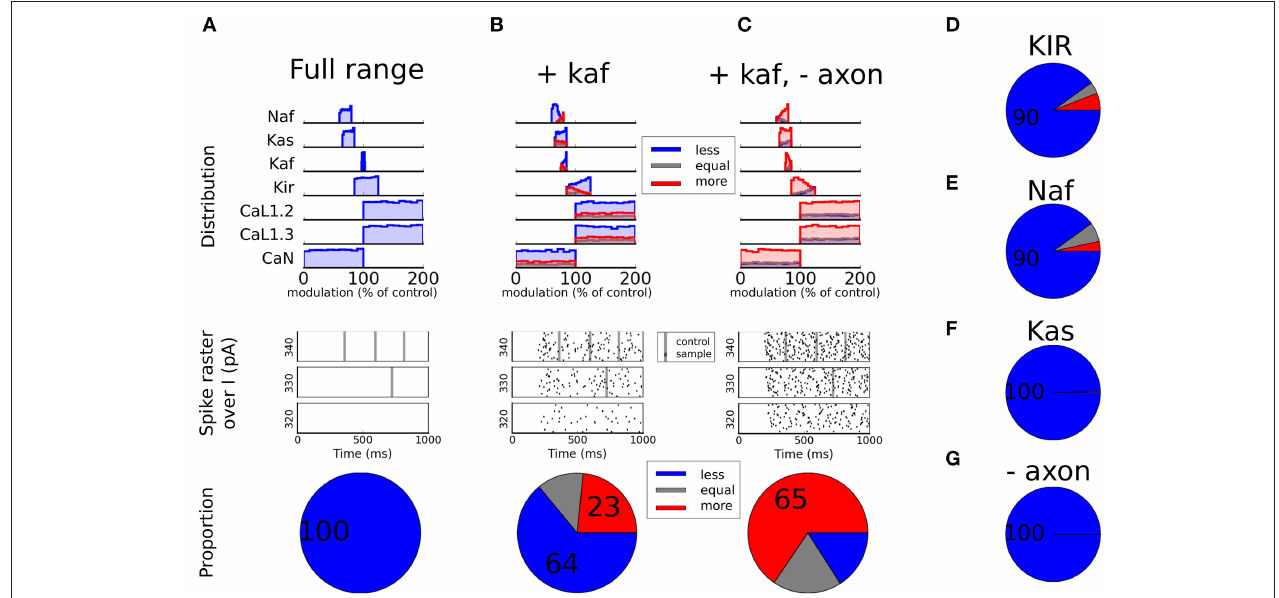
FIGURE 4 | Static modulation. In (A) , the modulation factors (MF) are restricted to the experimentally reported range (see Table 3 ) except for the Ca channels that are kept as free parameters since they did not contribute much to the excitability (see Figures 3C and D ). In the top panel the distribution of each channel is shown split over subgroup (L ess , E qual , or M ore excitable). The middle panel shows spike rasters. All black dots here represent spikes from modulated traces while the large gray stripes show the timing of spikes from the unmodulated control case. The bottom panel shows the proportion of the samples of each category. The same type of plots is shown in (B and C) but here the underlying sample sets have been restricted in different ways. In both plots the Kaf channel is also modulated 80 ± 5% and in (C) the axon initial segment is additionally not modulated. In (D) , the Kir channel is allowed to reduce more than reported in the literature (down to zero conductance). In (E) , the reduction of the fast sodium channel is allowed to reduce less than experimentally reported (up to no modulation). In (F) , the slow potassium channel (Kas) is allowed to reduce down to zero conductance. In (G) , the same modulation is used as in (A) , with the difference that the axon initial segment is not